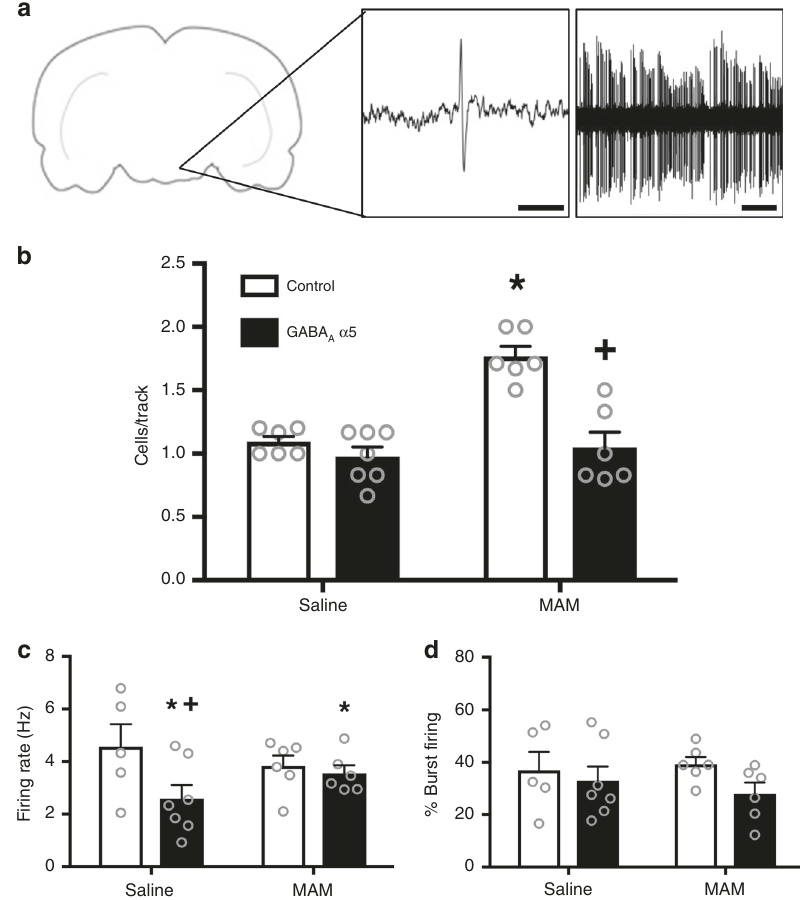
Fig. 2 α 5 overexpression normalizes dopamine cell activity in the MAM model of schizophrenia. Extracellular electrophysiology was used to record dopamine cell activity in the VTA. Representative traces are shown in a . In the MAM model of schizophrenia, the increase in the number of spontaneously active dopamine cells is attenuated by overexpression of the α 5 subunit in pyramidal cells of the vHipp ( b ). Asterisk is signi fi cantly different than saline/ control; + plus is signi fi cantly different than MAM/control. The average fi ring rate of dopamine cells was decreased by α 5 overexpression in both saline- and MAM-treated animals ( c ). Asterisk is signi fi cantly different than saline; + plus is signi fi cantly different than saline/control. The percentage of cells fi ring in a burst pattern was not affected by either MAM treatment or by α 5 overexpression ( d ). n = 6 – 7 rats per group. Scale bar is 10 ms. All data were analyzed using Two-Way ANOVA and Holm – Sidak tests. Data are shown as mean ±